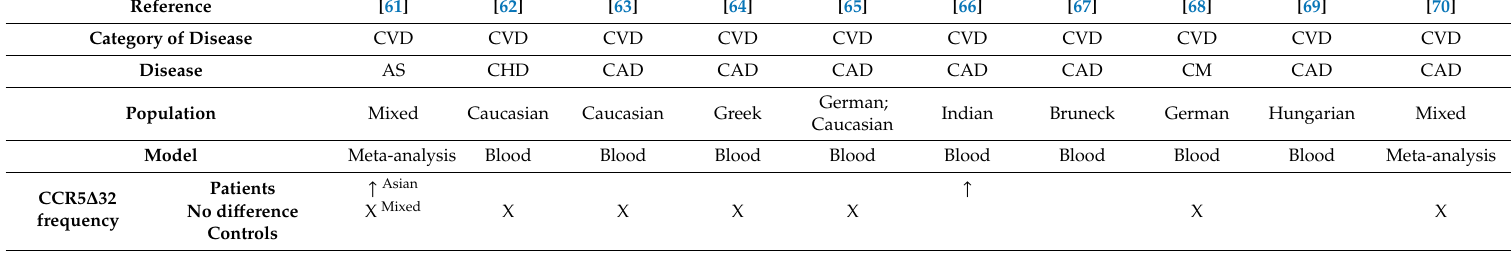
Table 1. The contrasting role(s) of C-C chemokine receptor 5 (CCR5) in di ff erent diseases possibly explained by CCR5 status (frequency, genotype, levels, haplotype), ethnicity, disease type and / or